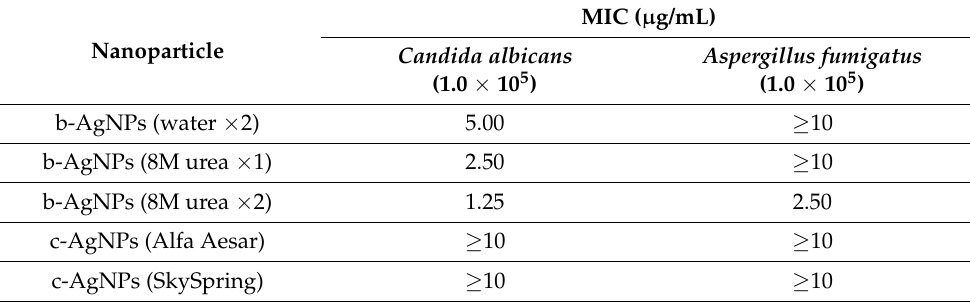
Table 4. Minimum inhibitory concentrations (MIC) of tested nanoparticles against Candida albicans yeast & Aspergillus fumigatus mold after 48 h incubation at 37 ◦ C in ambient air. MIC ( µ g/mL) Nanoparticle Candida albicans Aspergillus fumigatus